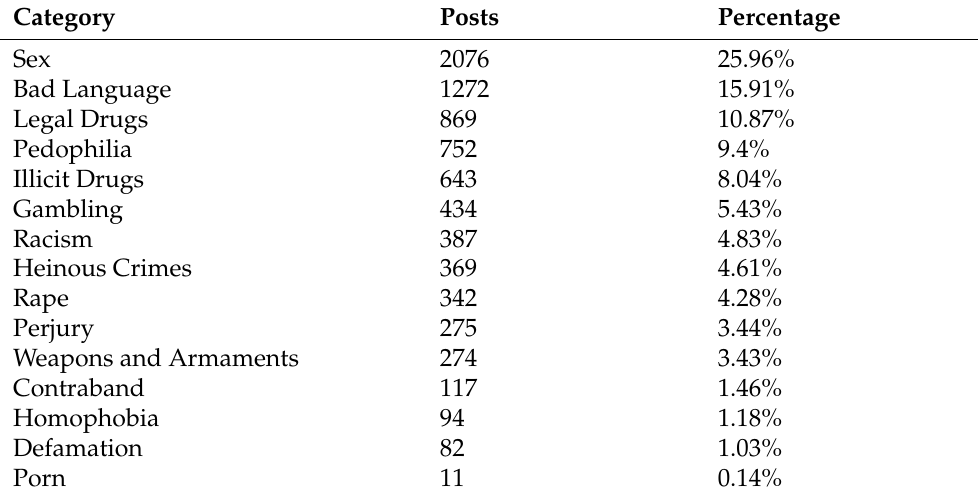
Table 3. Number of Occurrences that could be related to offensive language.